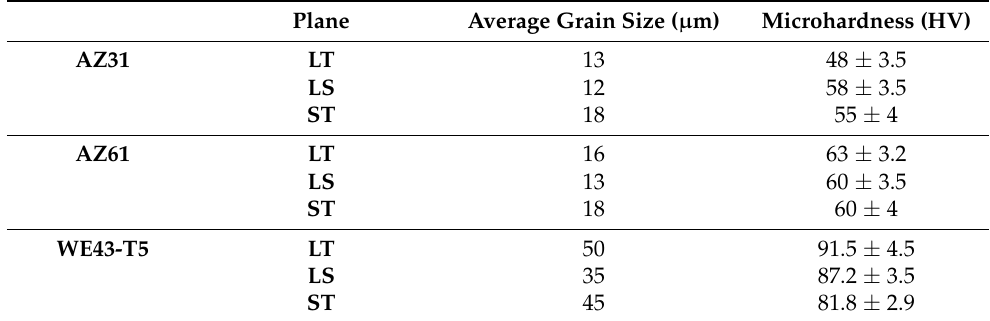
Table 3. Average grain size and microhardness of alloys AZ31, AZ61, and WE43-T5.